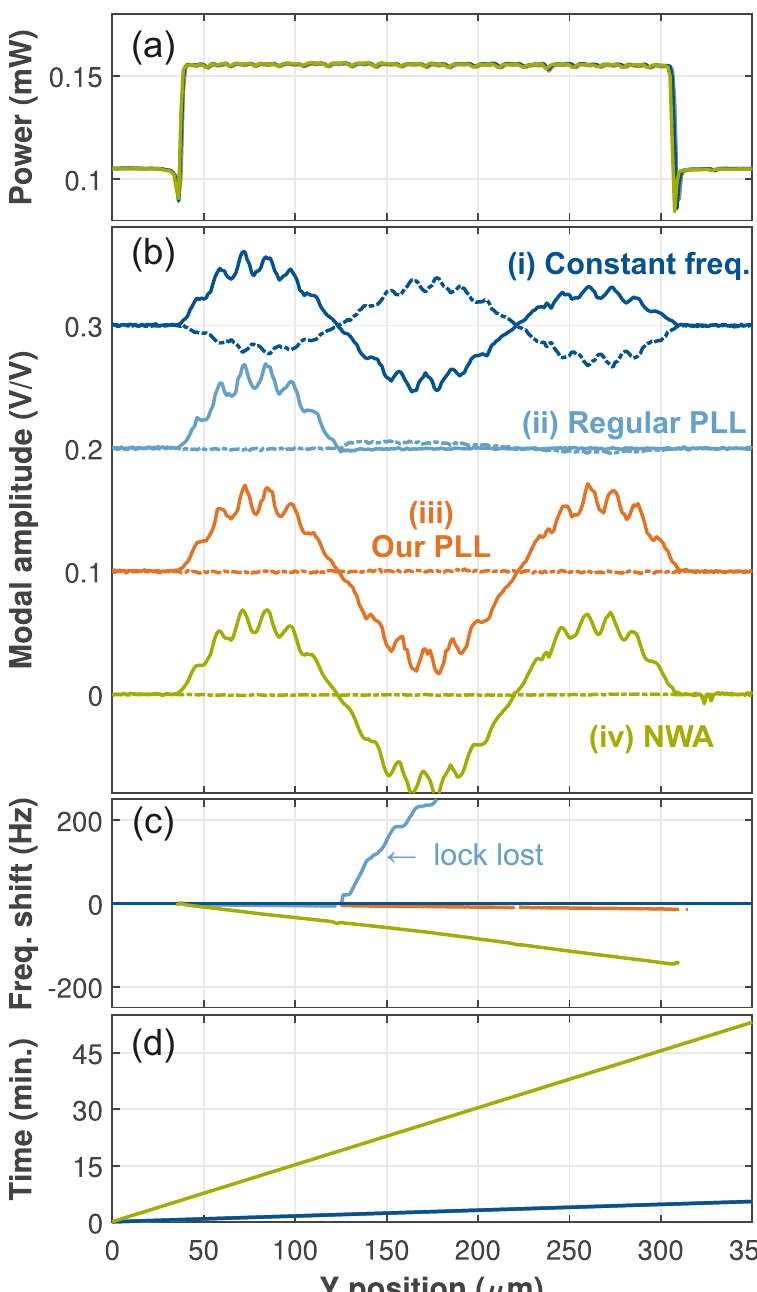
Figure 2. Line traces over the membrane for (i) constant frequency (dark blue), (ii) regular PLL (light blue), (iii) the modified PLL with mod 180° (orange), (iv) data measured using a network analyzer (green). ( a ) Reflected laser power. ( b ) The mode profile of the (1,3) mode near 3.26 MHz. Solid (dashed) lines indicate the real (imaginary) part. The curves are offset for clarity. ( c ) Frequency change during the measurement. For (i)–(iii), this was the actuation f , whereas for (iv) the resonance f 0 was extracted from the NWA traces. By definition the frequency was constant in (i). ( d ) Elapsed time since the start of the